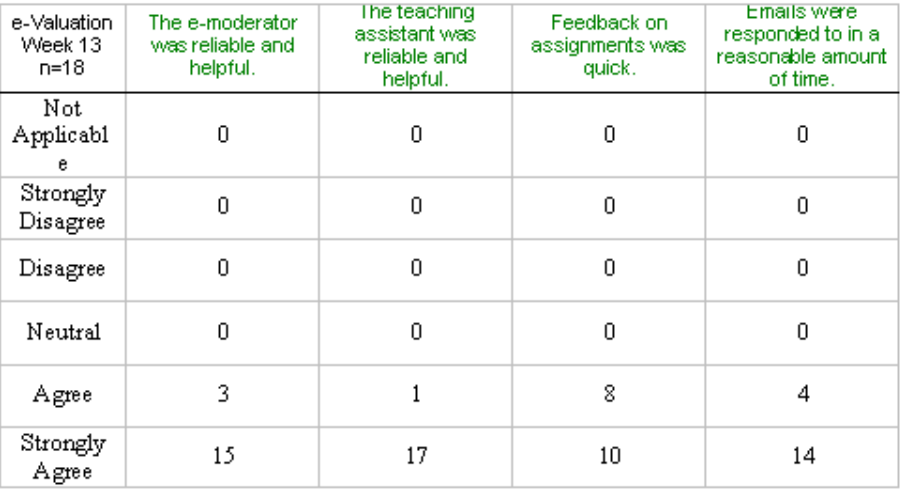
Table 4. Perceptions of